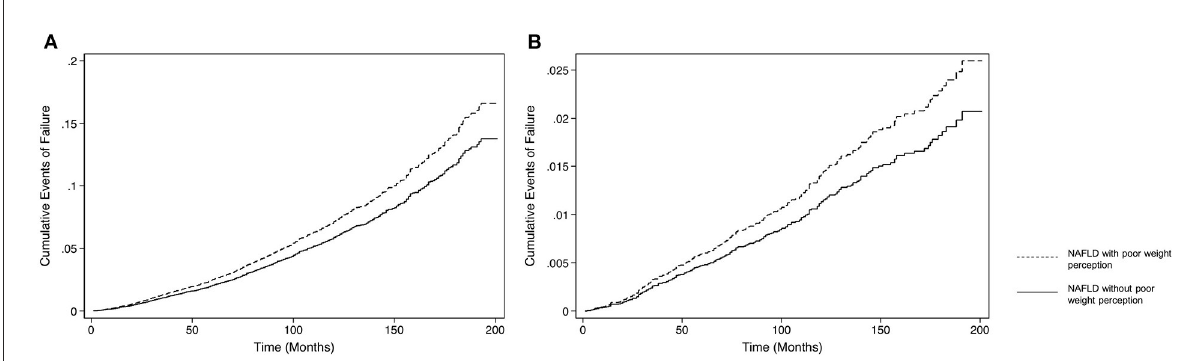
FIGURE1 Incidence of all-cause mortality in NAFLD individuals with and without poor weight perception. (A) Survival analysis of all-cause mortality. (B) Survival analysis of CVD mortality.